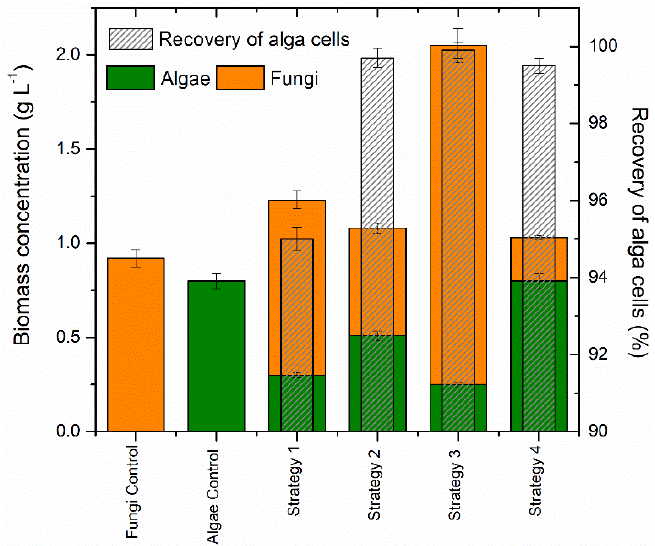
Figure 4. Summary of results according to biomass accumulation and distribution fungi (orange), algae (green) and % recovery of algae cells (grey).